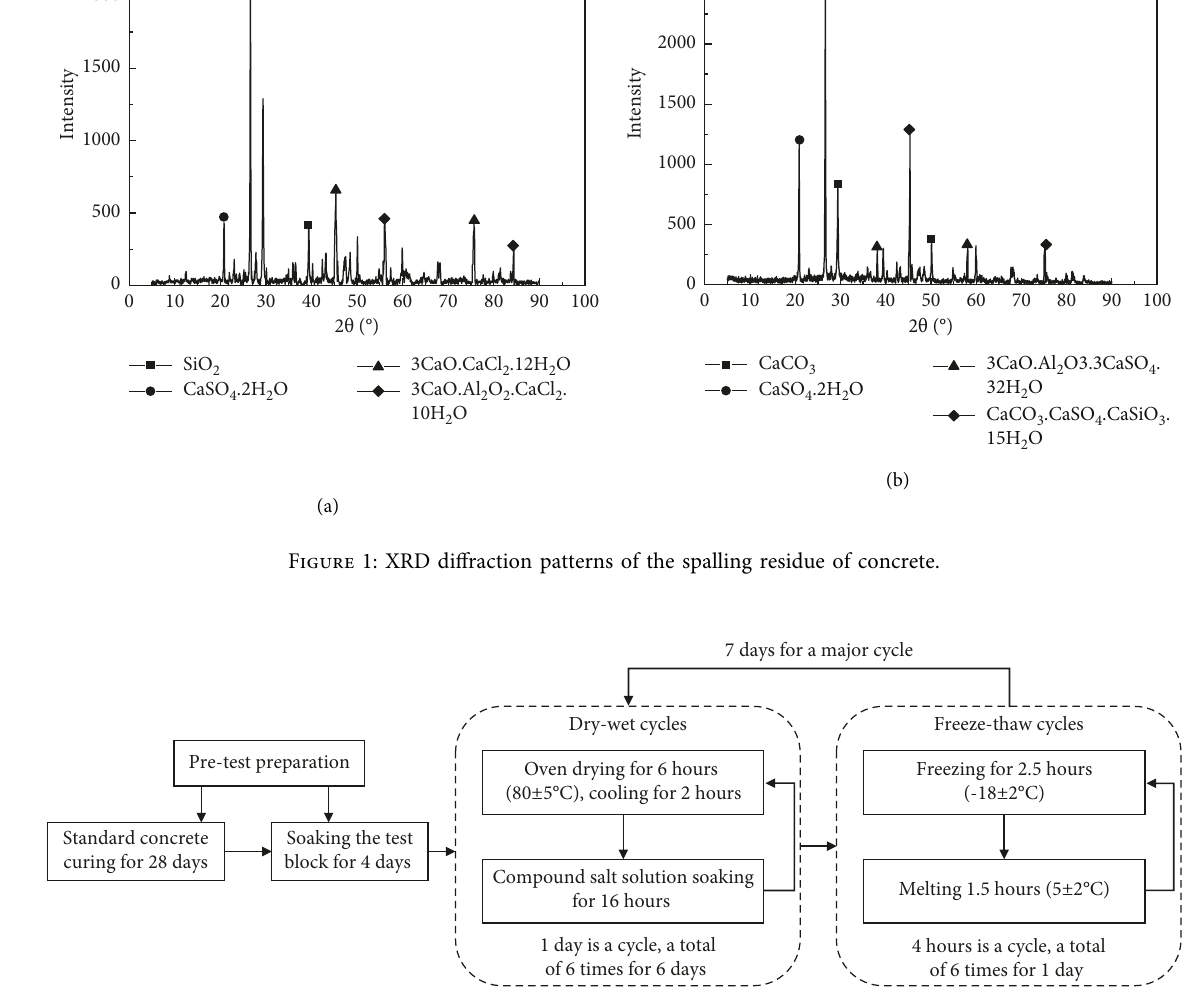
Figure 2: The dry-wet-freeze-thaw cycles test system.